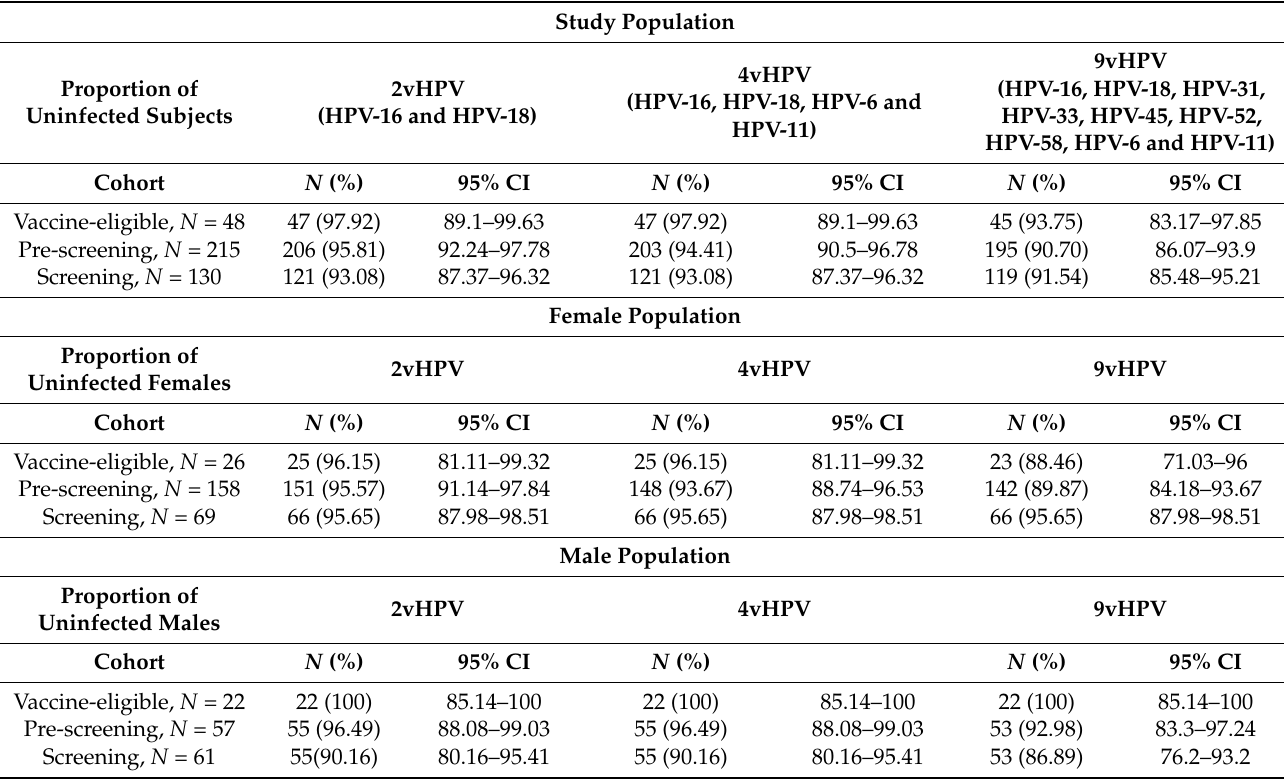
Table 4. Proportion of subjects free from high-risk HPV vaccine types (2-, 4- and 9-valent vaccines) broken down by cohort and